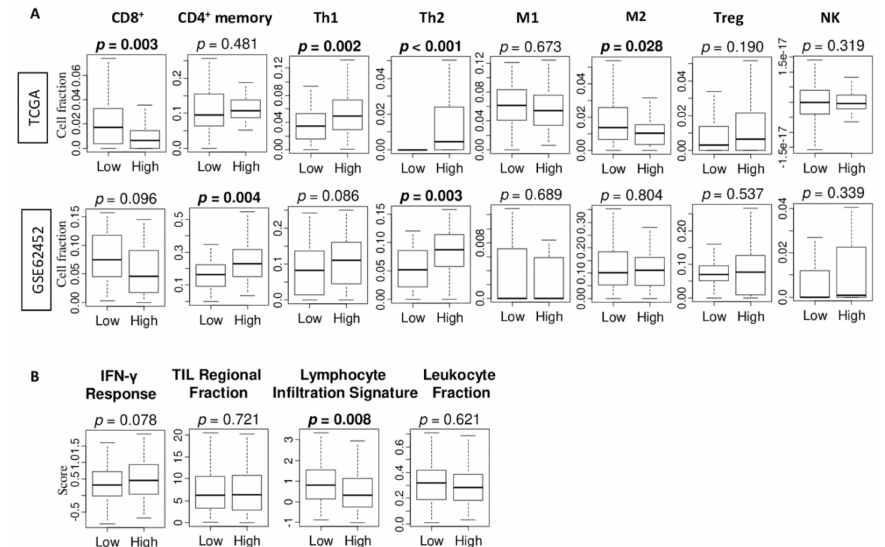
Figure 4. The association of G2M pathway score with tumor infiltrating immune cells estimated by xCell algorithm and immune function scores in the TCGA and GSE62452 cohorts. ( A ) Boxplots of the estimated amount of CD8 T cell, CD4 memory T cell, type 1 helper T cell (Th1) and type 2 helper T cell (Th2), M1 and M2 macrophage, regulatory T cell, and natural killer T cell by low and high G2M pathway scores. ( B ) Boxplots of scores: interferon ( IFN )- γ response, tumor infiltrating lymphocyte ( TIL ) regional fraction, lymphocyte infiltration, and leukocyte fraction by low and high G2M pathway score. High and low score groups were divided by the median value. Tukey-type boxplots show median and inter-quartile level values, and the ANOVA test is used to calculate p